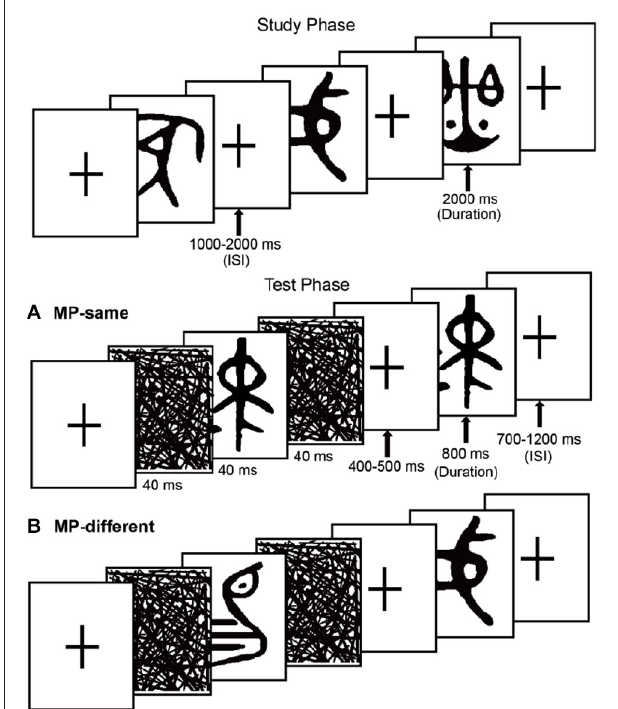
FIGURE 1 | Schematic representation of the experiment, showing examples of the stimuli . The task in the study phase was to rate meaningfulness. The test phase task was to make recognition judgments. (A) MP-same trials, the unstudied test items preceded by matching masked primes. (B) MP-different trials, the test items preceded by nonmatching masked